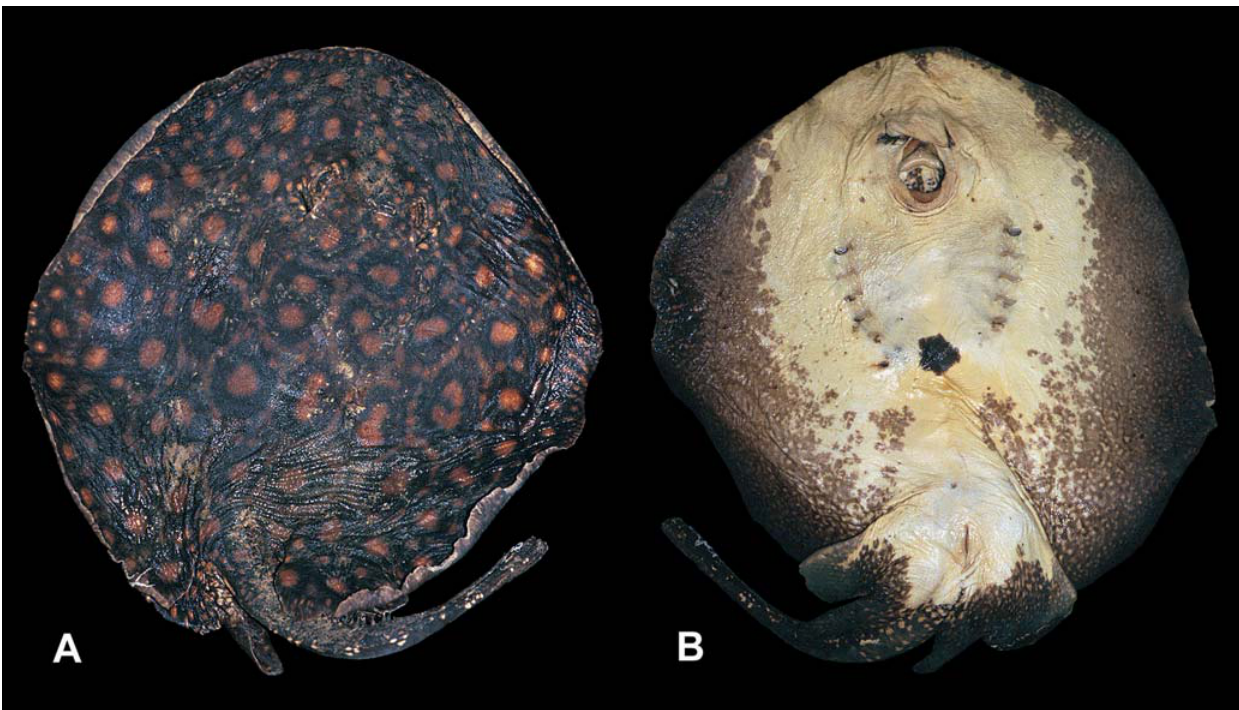
Fig. 1. Potamotrygon boesemani . Dorsal ( A ) and ventral ( B ) views of holotype (USNM 225574, 377 mm DW), Corantijn